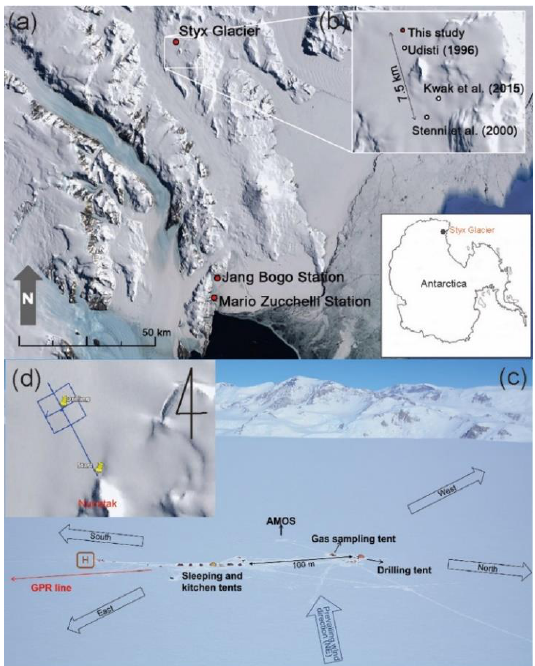
Figure 1. Maps of the drilling site, modified from Han et al. [40] . ( a ) The Styx Glacier in northern Victoria Land lies along the western margin of the Ross Sea. The sample locations of Udisti [45] , Stenni et al. [38] and Kwak et al. [36] in ( b ) are marked for comparison. ( c ) The site where samples were collected, showing the various tents during the 2014–2015 summer expedition. GPR: ground-penetrating radar; AMOS: automatic meteorological observation system. ( d ) Investigation lines for ground penetrating radar (GPR). Details of the measurements and results will be presented in Figure